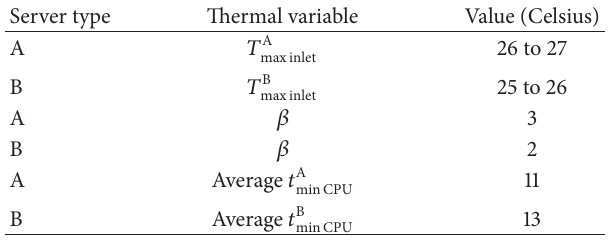
Table 3: Thermal variables gathered from ITE test.